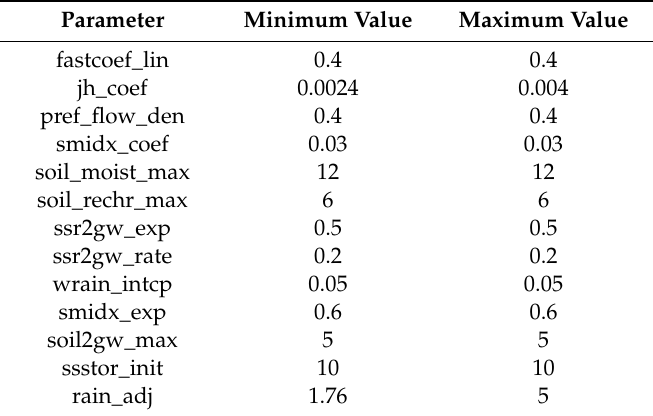
Table 1. The ranges of the calibrated parameters for the groundwater and surface water flow (GSFLOW) model. Note that other parameters that are not on the list used the default values proposed by Markstrom et al. (2008)